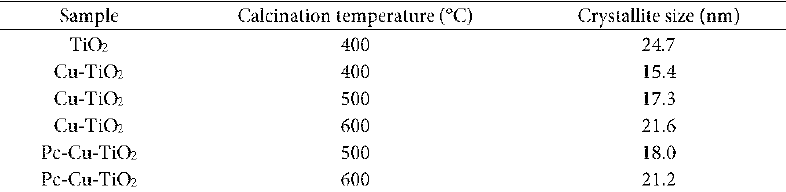
Table 1. Crystallite size of samples calculated using the Scherer